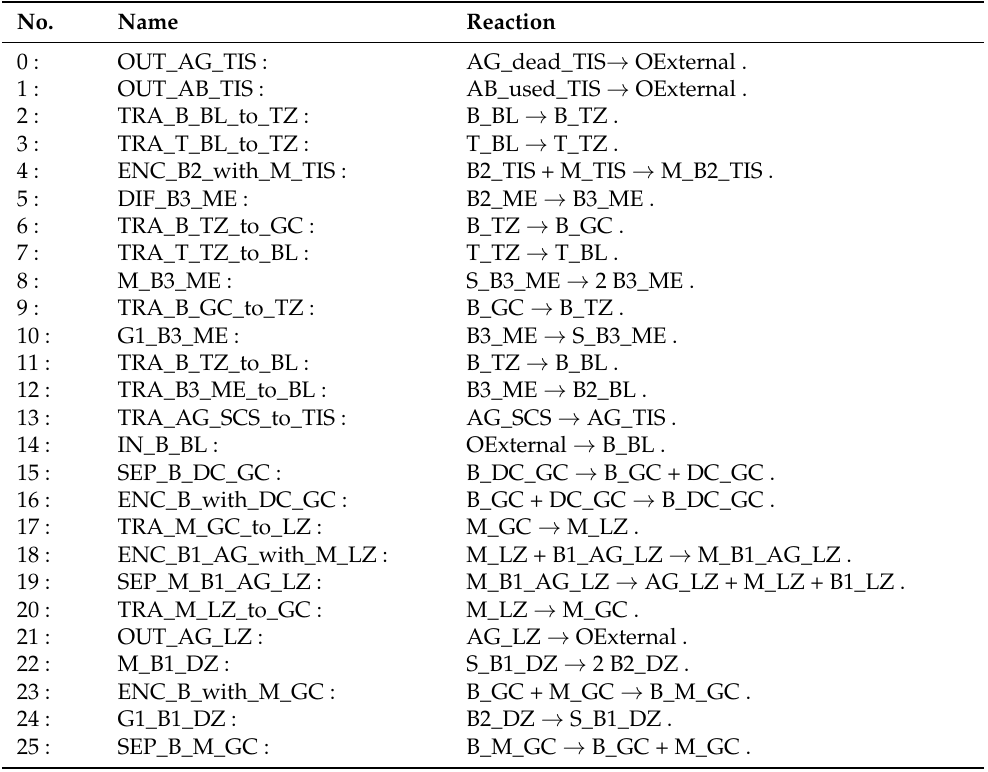
Table A3. Reaction system. The species “OExternal” denotes the interface to the environment. “OExternal” is ignored for preconditions and token